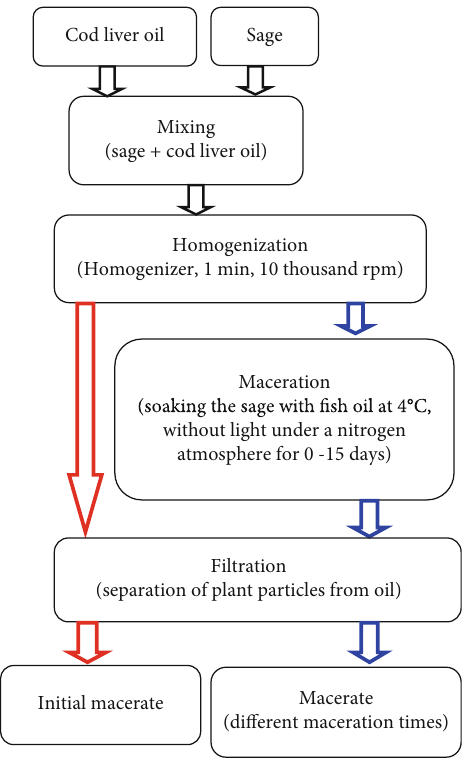
Figure 1: Formation of